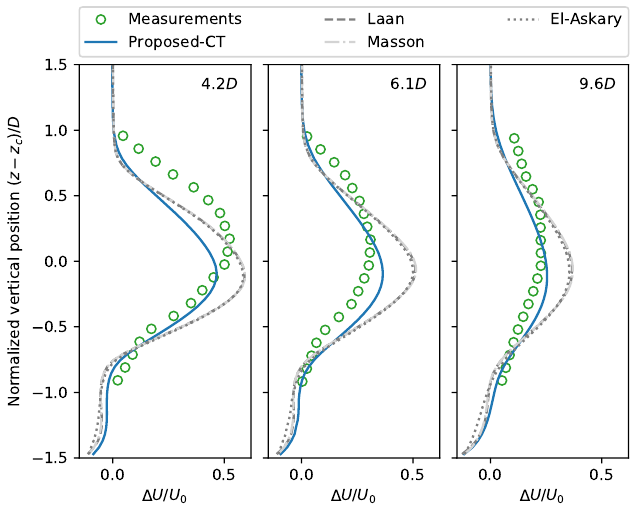
Figure 16. Same as Figure 15 but for vertical wake deficit